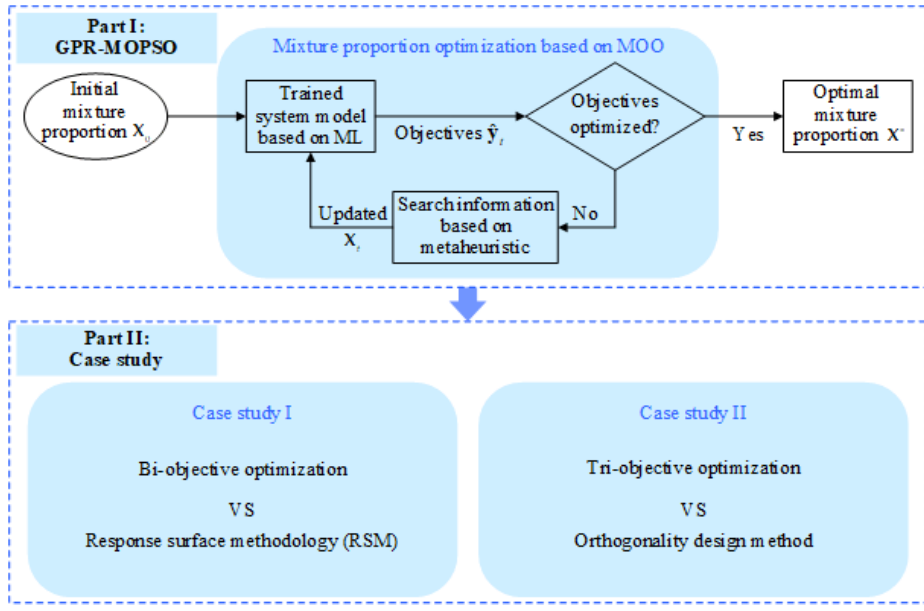
Figure 1. The study structure of metaheuristic optimization based on the machine learning (ML)